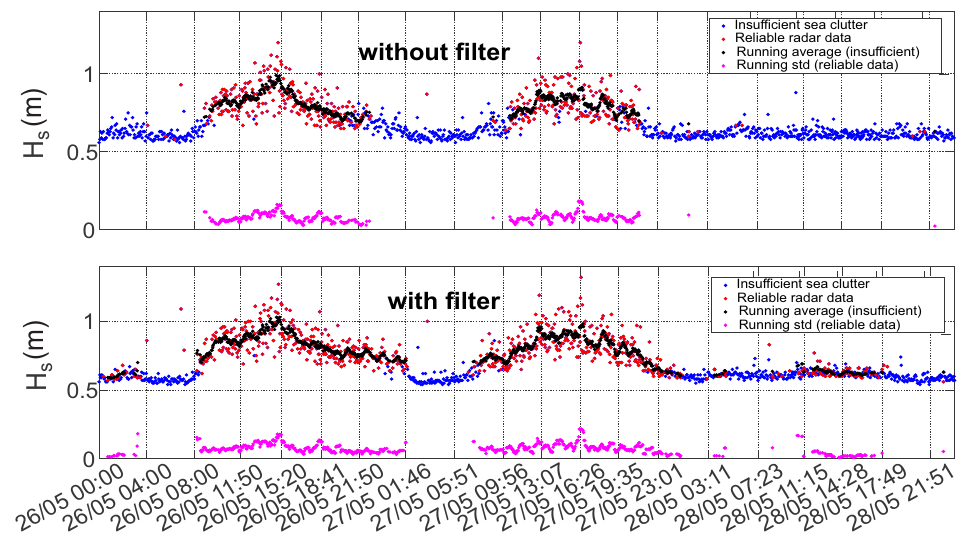
Figure 11. Time series of the significant wave height before ( upper panel ) and after ( lower panel ) streak filtration given together the moving average and std with the 20 min window size.